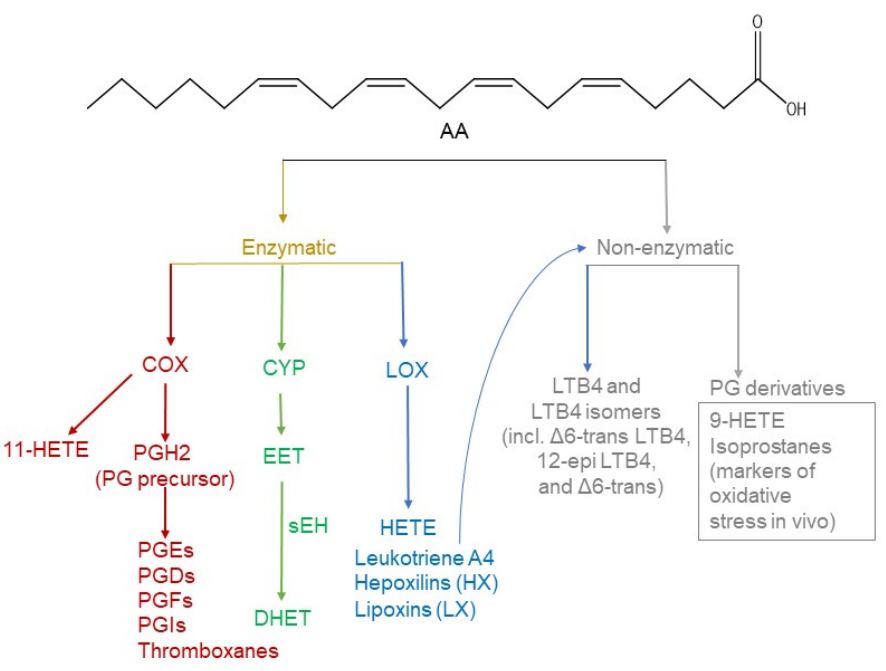
Figure 2. Arachidonic acid is the main precursor of eicosanoids. Eicosanoids can be produced enzymatically by COX, LOX, and CYP, and non-enzymatically. COX-derived eicosanoids include prostaglandins as well as 11-hydroxyeicosatetraenoic acid (HETE). CYP enzymatic activity produces EETs that are further hydrolysed to DHET by soluble epoxide hydrolase (sEH). HETEs, leukotrienes, hepoxilins, and lipoxins are produced by LOX. Leukotriene A4 is subjected to further non-enzymatic hydrolysis to form Leukotriene B4 LTB4 and its derivatives. Non-enzymatic oxidation of AA results in the formation of eicosanoids used as markers of oxidative stress in vivo. Chemical formula for AA was created using ChemDraw ® .